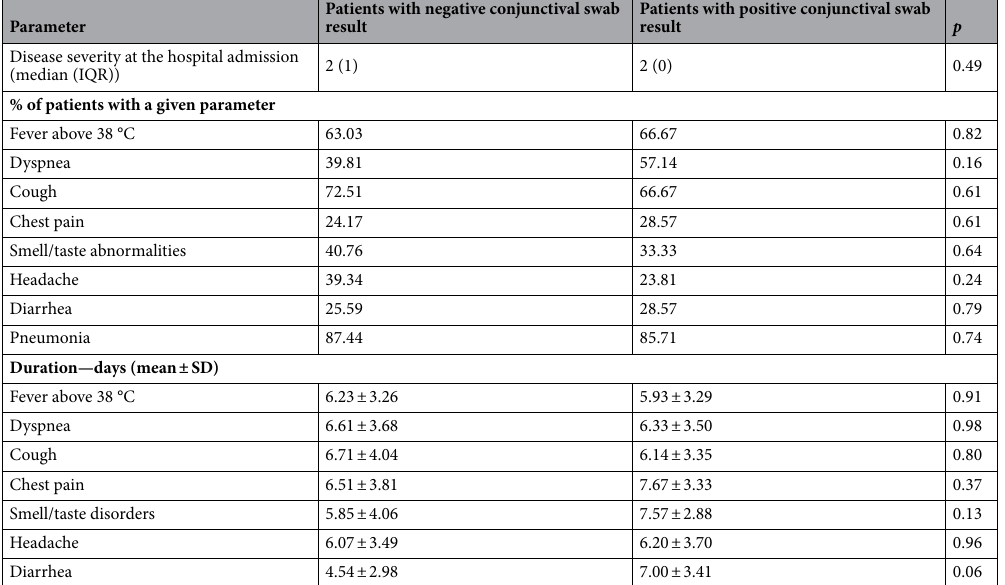
Table 2. Data regarding disease severity and the presence and duration of COVID-19 symptoms in patients with positive and negative conjunctival swab results.